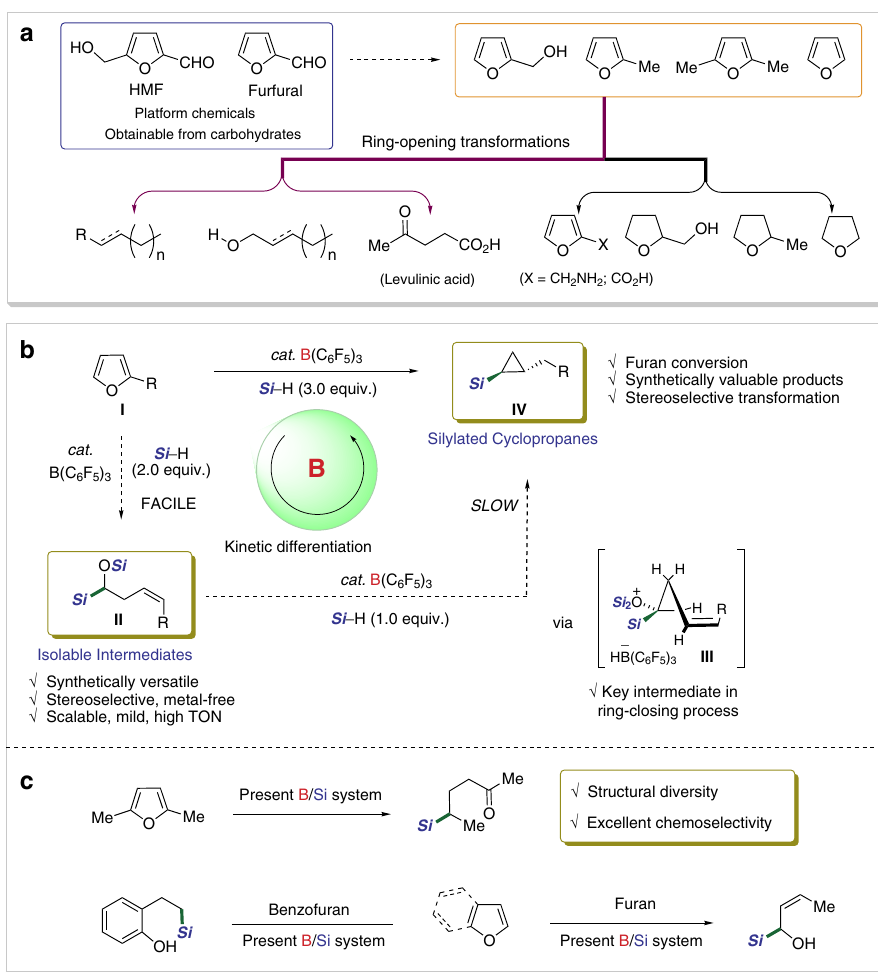
Figure 1 | Furans from biomass resources and their transformations. ( a ) Furan platform chemicals and known post-transformations leading to diverse synthetic valuables. ( b , c ) Present work; Borane-catalysed ring-opening and closing cascades of furans giving rise to synthetically valuable silicon compounds in reaction with hydrosilanes ( Si ¼ SiR 0 2 R 00